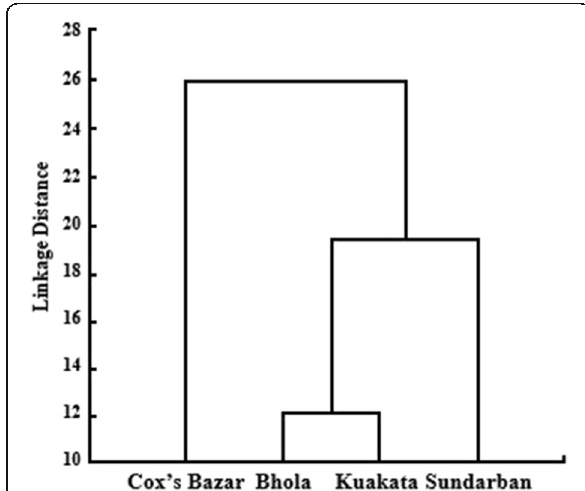
Fig. 7 Dendrogram resulting from the cluster analysis of Euclidean distances among A. clupeoides collected from the four sampling points along the Bay of Bengal coast,